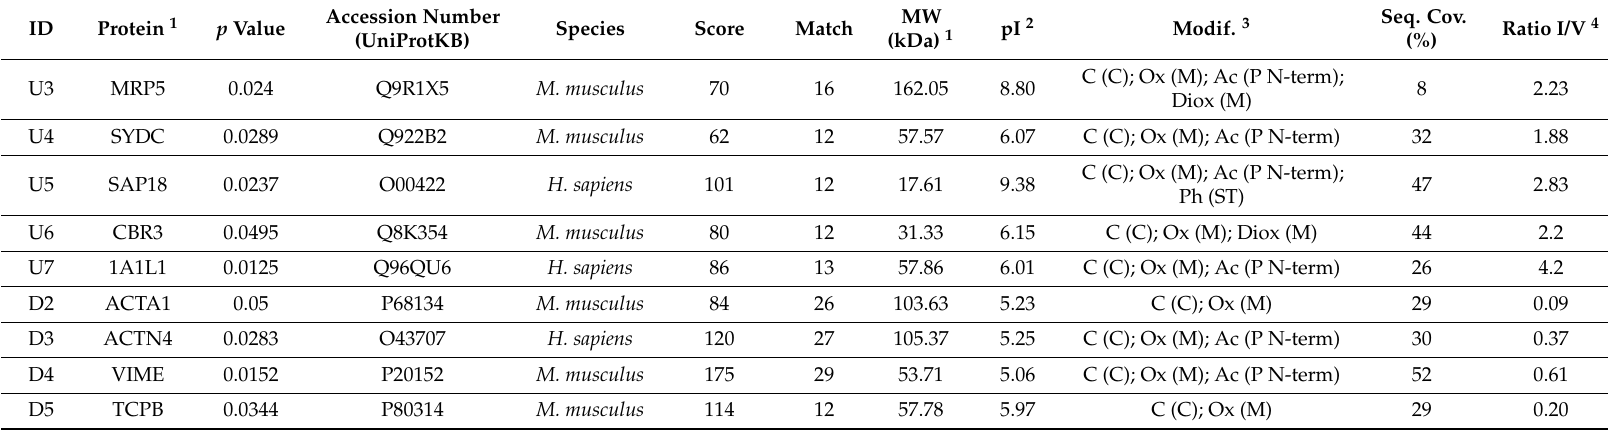
Table 2. Significantly ( p ≤ 0.05) differentially expressed proteins in feline fibrosarcomas from the FFS1 cell line versus the FFS5 cell line identified by MALDI-TOF MS